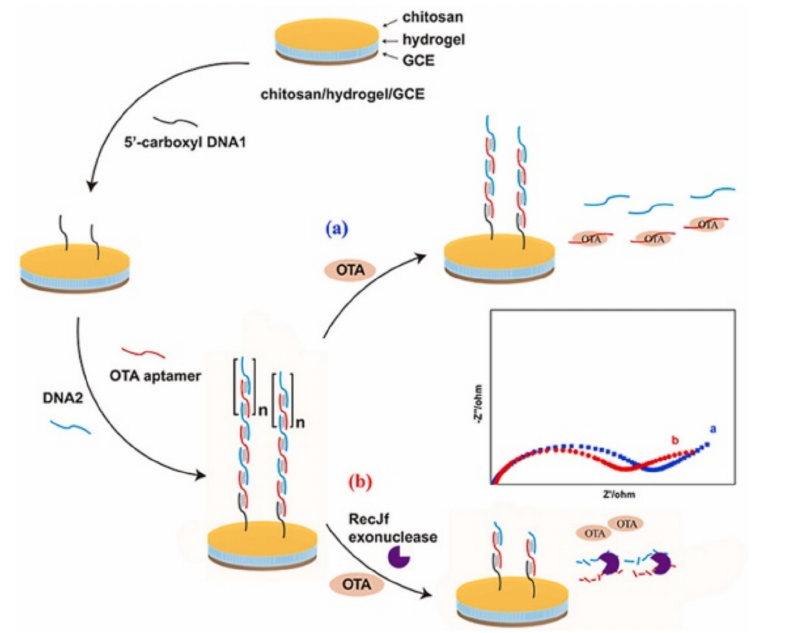
Figure 8. OTA analysis steps of the impedimetric electrochemical sensor. Reprinted with the permission from reference [96]. Copyrigt 2021